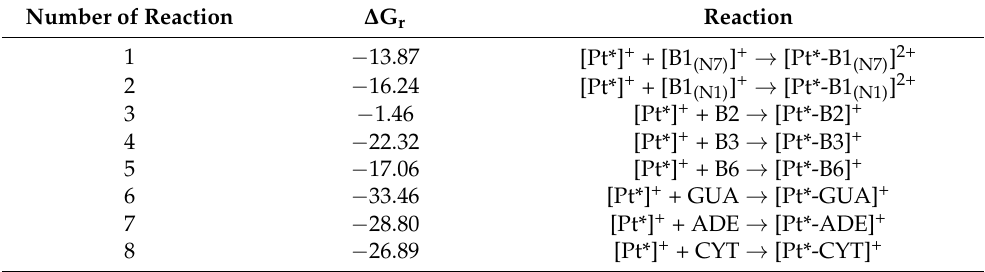
Table 1. The energetic characteristics of the Pt-Chloroaqua reactions with vitamin B and nucleobases obtained at the B3LYP/6-31G(d,p)/LANL2DZ level of theory. All energies are given in kcal/mol. Symbol Pt* stands for PtClDACH.